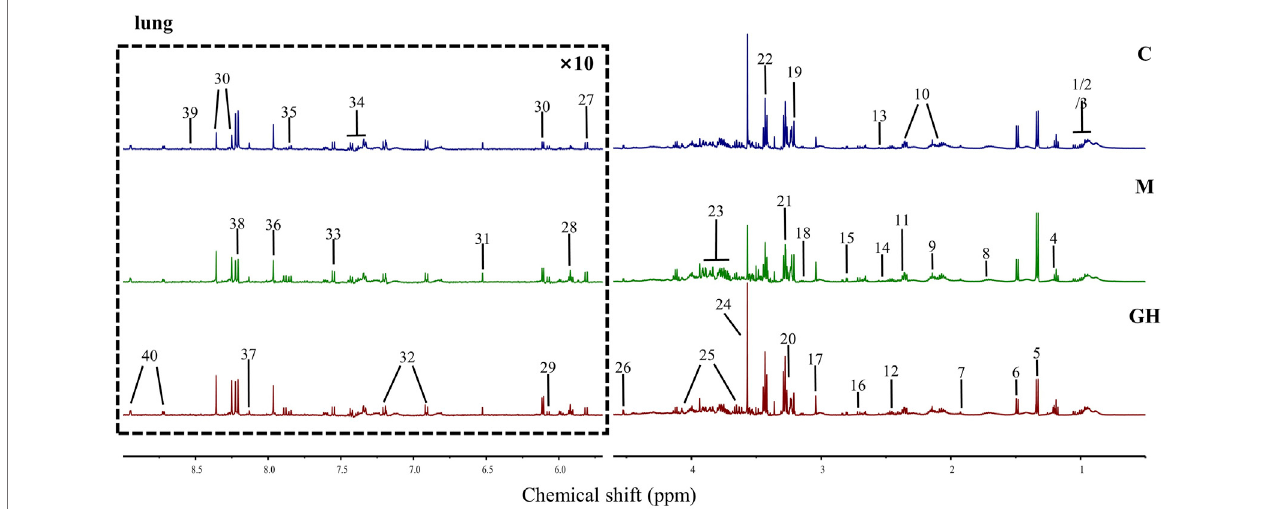
FIGURE 2 | 1 H-NMR map and identi fi ed metabolites of rat lung tissue. The metabolites in the lung tissue in the picture were as follows: 1 Isoleucine (Ile), 2 Leucine (Leu),3Valine(Val),43-Hydroxybutyrate(3-HB),5Lactate(Lac),6Alanine(Ala),7Acetate(AC),8Lysine(Lys),9Methionine(Met),10Glutamate(Glu),11Pyruvate(Pyru), 12 Glutamine (Gln), 13 Glutathione (GSH), 14 Isocitrate, 15 Aspartate (Asp), 16 dimethylamine (Dma), 17 Creatine/Phosphocreatine (CP), 18 Ethanolamine (MEA), 19 Choline, 20Betaine (Bet), 21 TrimethylamineN-oxide (TMAO), 22Taurine (Tau), 23 Glucose (Glc), 24Glycine(Gly), 25 Myo-inositol,26 Ascorbate,27 Uracil (U), 28 Uridine, 29 Adenosine, 30 Inosine, 31 Fumarate (Fum), 32 Tyrosine (Tyr), 33 Tryptophan (Try), 34 Phenylalanine (Phe), 35 Cytidine, 36 Xanthine (Xan), 37 Carnosine (Carn), 38 Hypoxanthine (Hyp), 39 Formate (FA), 40 Nicotinamide/Nicotinurate (vpp).